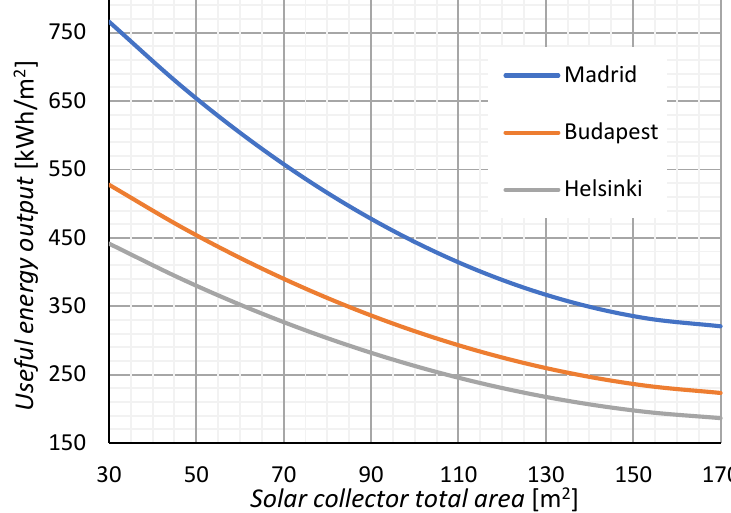
Figure 12. The influence of the collector surface area on an annual useful energy output.